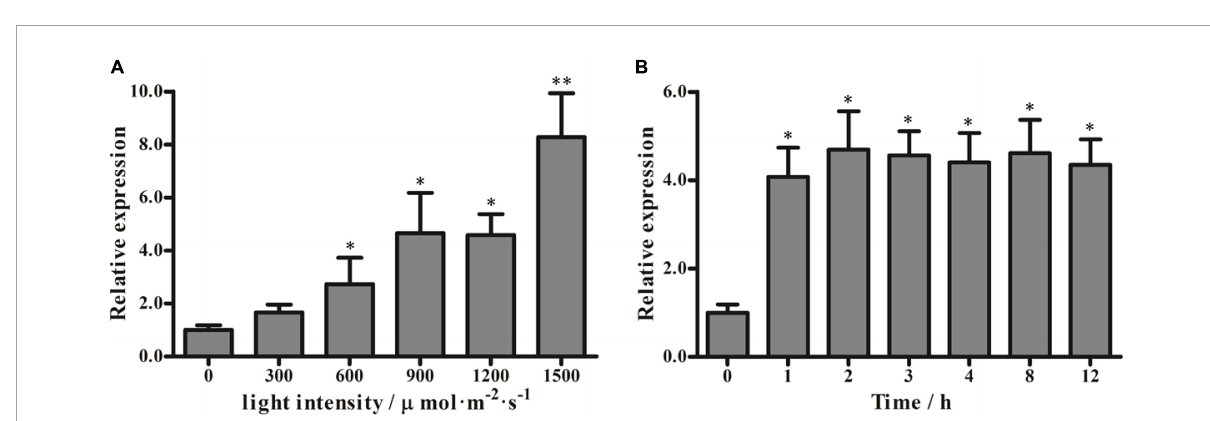
FIGURE3 Transcript levels of PeVDE in moso bamboo leaves under different light conditions. (A,B) PeVDE expression in leaves treated with different light intensities (0, 300, 600, 900, 1,200, and 1,500 µ mol · m − 2 · s − 1 ) for 2 h (A) , and with high light intensity (1,200 µ mol · m − 2 · s − 1 ) for up to 12 h (B) . Asterisks indicate significant differences ( ∗ p < 0.05, ∗∗ p <